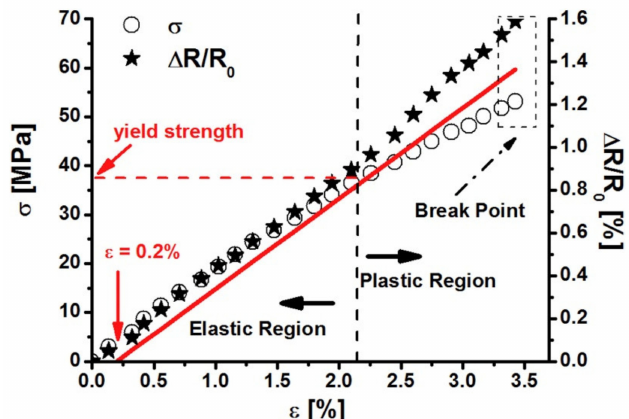
Figure 7. Mechanical response (i.e., σ , left vertical axis) and normalized change of electrical resistance (i.e., ∆ R/R 0 , right vertical axis) observed in tensile stress as a function of the axial strain ( ε )